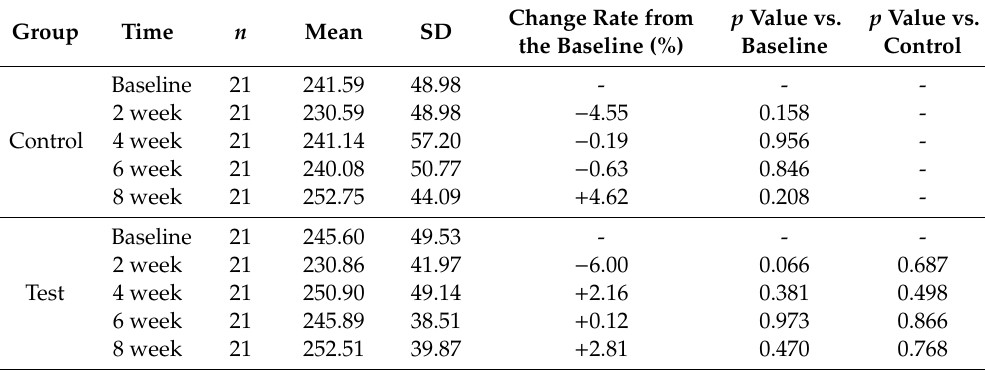
Figure 2. Changes in skin color parameters of the facial skin during application of test and control products. Melanin index ( a ), erythema index ( b ), L* value (light ness) ( c ), a* value (redness) ( d ), and b* value (yellowness) ( e ) were determined by instrumental analysis. ITA ◦ (skin color) ( f ) was calculated from L* and b* values. Skin color parameters are plotted against time (weeks). Data are presented as mean ± SD ( n = 21). The p values of the control group and test group versus the baseline values before the start of the test are shown in blue and black letters, respectively, if they are less than 0.The p values of the test group versus the control group at each time point are shown in red letters if they are less than 0.05. Table 5. Erythema index of the control and test